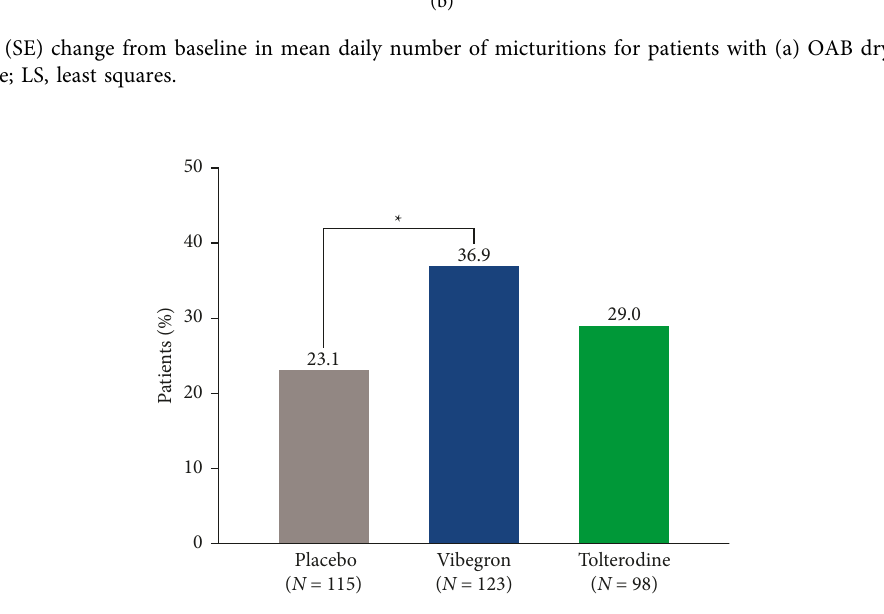
Figure 3: Percentage of patients with OAB dry achieving ≥ 50% reduction from baseline in mean daily urgency episodes. ∗ P < 0.05 vs. placebo using mixed model for repeated